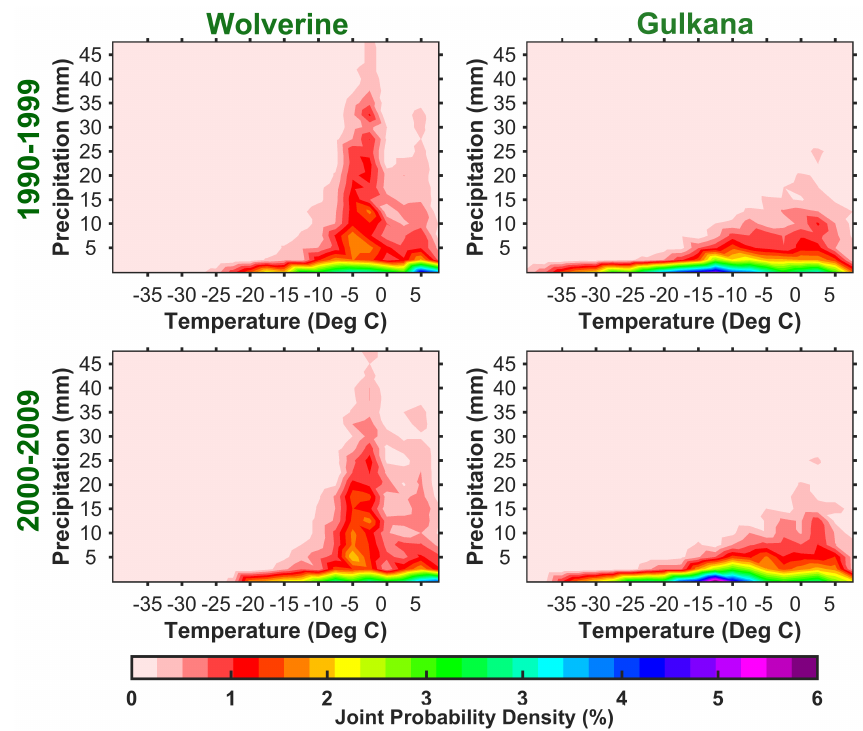
Figure A1. Joint distribution function of daily precipitation and mean surface air temperature for Gulkana and Wolverine watersheds (Fig. 1) from 1980 to 1989 and 1990 to 2009. The precipitation and temperature values are spatially averaged over each watershed. Climate repre- sentation is derived from the daily downscaled Climate System Forecast Reanalysis (Saha et al., 2010) product discussed in Sect.